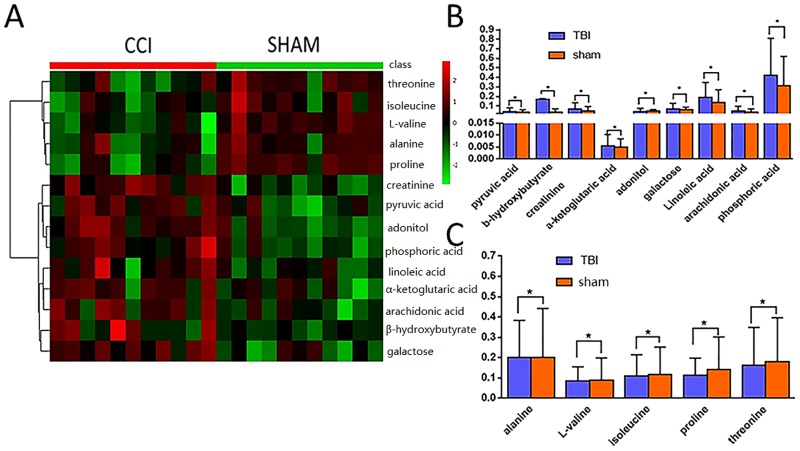
Performances of statistically significant metabolites in acute TBI.(A) Hierarchically clustered heatmap of 14 statistically significant metabolites. Sham-operated (green) and TBI-injured (red) animals clustered into separate clusters. From top down, the relative concentrations of threonine, alanine, isoleucine, L–valine, and proline increased successively, and the relative concentrations of β-hydroxybutyrate, adonitol, creatinine, arachidonic acid, α-ketoglutaric acid, pyruvic acid, galactose, phosphoric acid, and linoleic acid successively decreased. (B) Bar graphs of statistically significant metabolites: the values in the acute TBI group were greater than those in the sham group. (C) Bar graphs of statistically significant metabolites: the values in the acute TBI group were lower than those in the sham group.